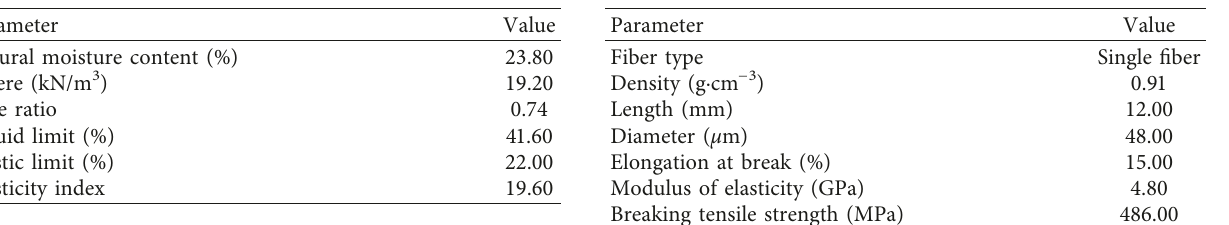
Table 3: Physical properties of polypropylene fibers. Table 1: Physical properties of clay.